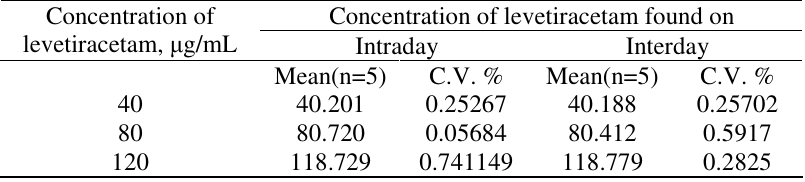
Table 4 . Inter and intra day precision for levetiracetam by the proposed HPLC method.